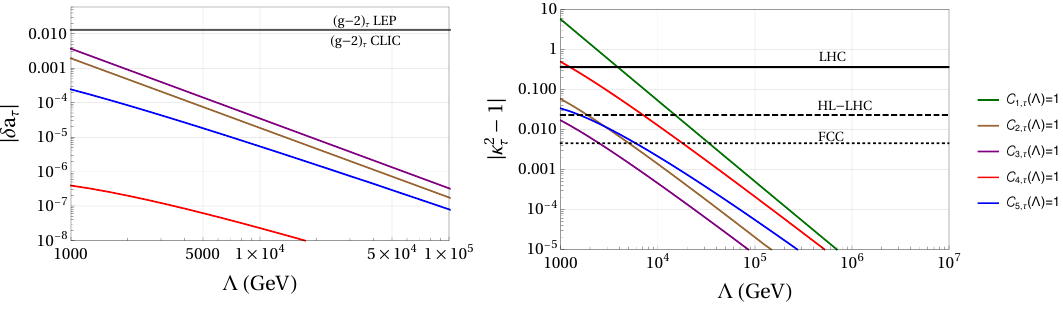
Figure 6 . Left : induced shift in the tau anomalous magnetic moment from δc 2 ,τ as function of the NP scale Λ . The horizontal lines show the upper bounds from LEP and CLIC, see eq. (4.7). Right : induced shift in Higgs to two taus decay from δc 1 ,τ as function of the NP scale Λ . The horizontal solid line shows present bounds from measurements at LHC, while dashed and dotted lines show projections from HL-LHC and FCC